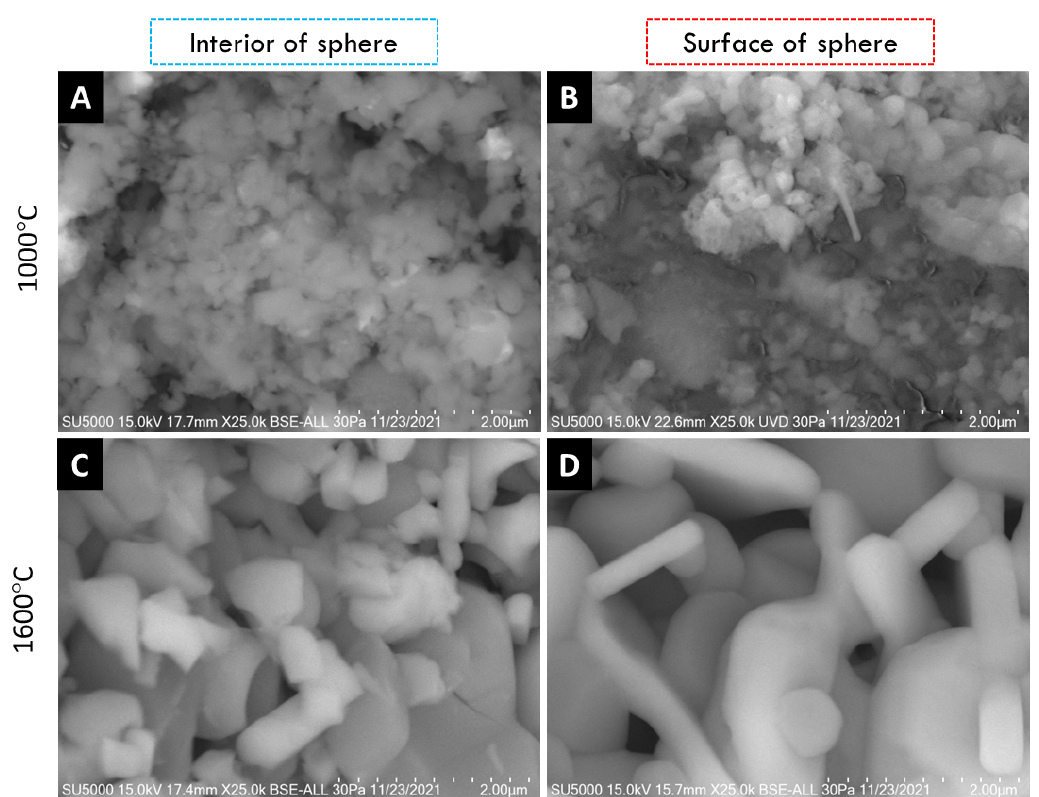
Figure 8. SEM micrographs of alumina spheres treated at 1000 °C ( A , B ) and 1600 °C ( C , D ).